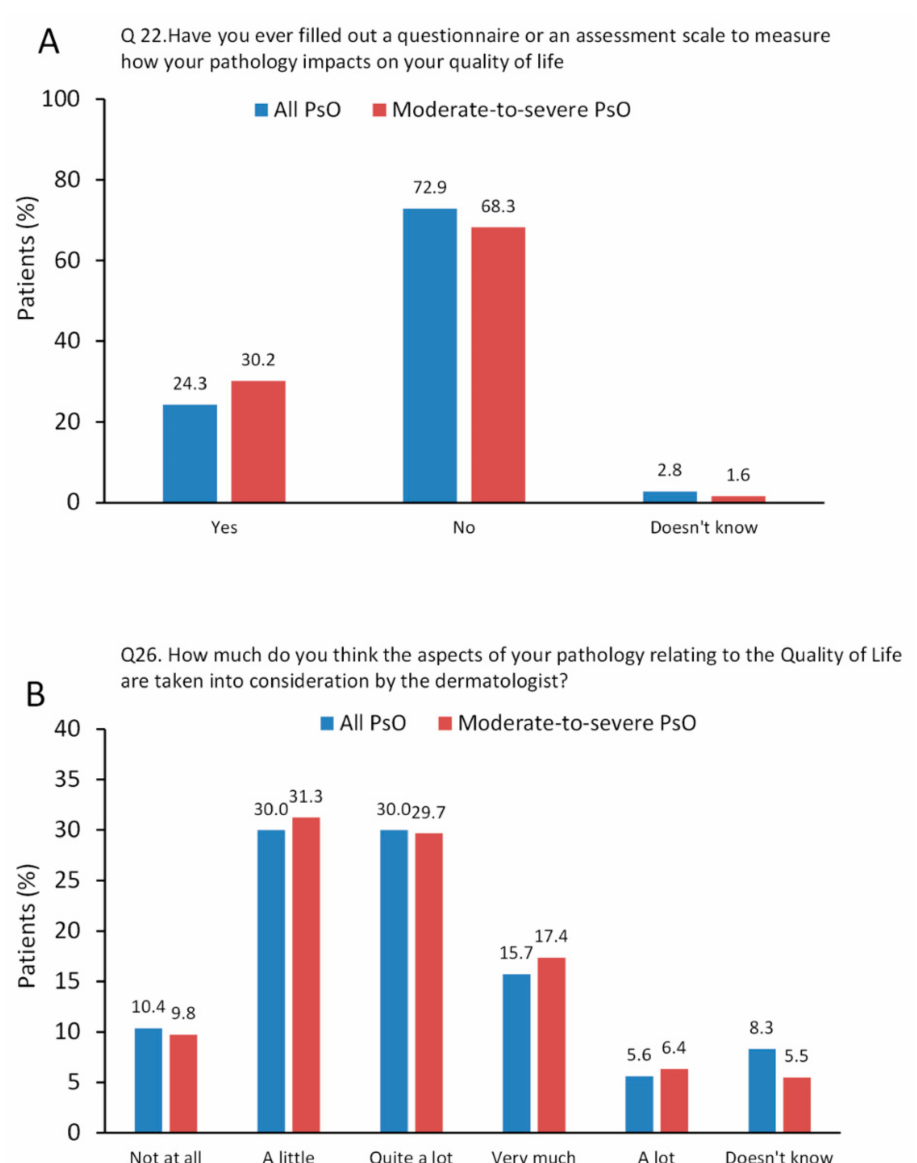
Figure 3. Results from questions/statements related to Questions no. 22 and 26 from the